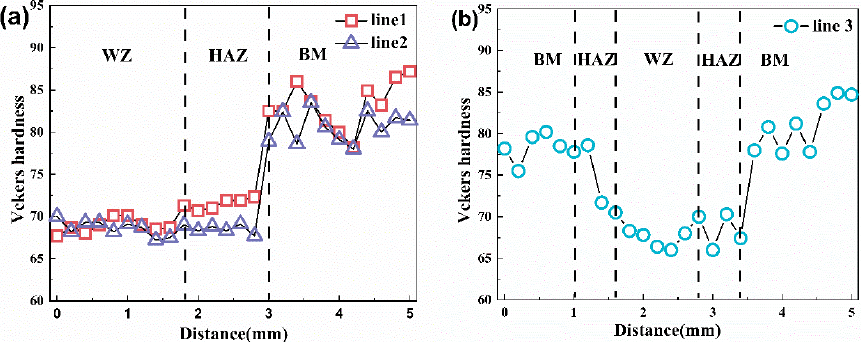
Figure 4. ( a ) The hardness value distribution of line 1 and line 2 in Figure 1; ( b ) Hardness value distribution diagram of line 3 in Figure 1. distribution diagram of line 3 in Figure